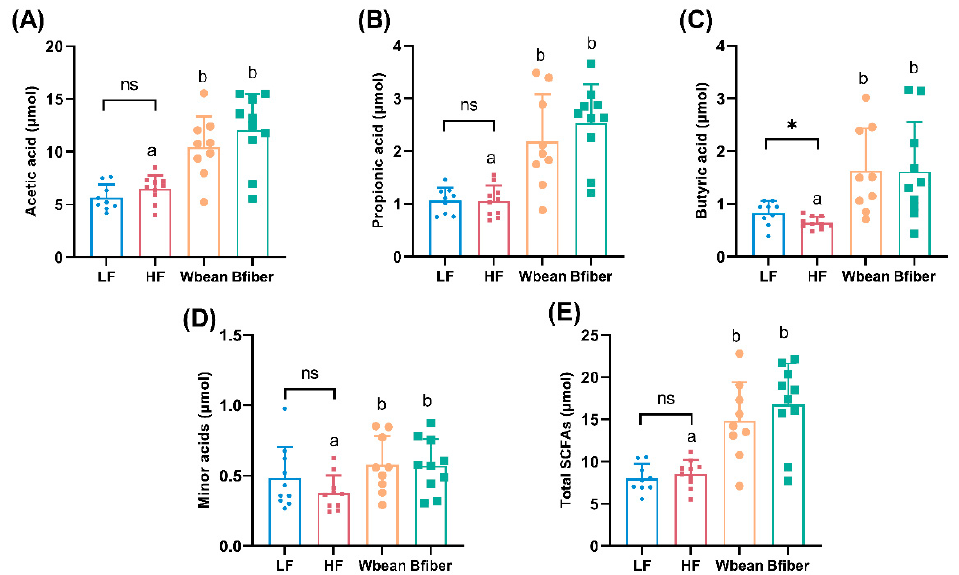
Figure 2. Cecal pools ( µ mol) of ( A ) acetic acid, ( B ) propionic acid, ( C ) butyric acid, ( D ) minor acids and ( E ) the total short-chain fatty acids (SCFAs) in Apoe − / − mice fed a control diet (low fat (LF) or high fat (HF)) or a bean diet (whole brown bean (Wbean), bean fiber (Bfiber)) in a HF setting for 10.5 weeks. Minor acids include isobutyric acid, valeric acid, isovaleric acid, caproic acid, and heptanoic acid. Values in the LF and HF controls were compared using Student’s t -test. Values in the high fat groups, i.e., HF, Wbean, and Bfiber, were compared using one-way ANOVA followed by Tukey’s multiple comparison test. Different lowercase letters and symbol (*) within panels indicate significant differences ( p < 0.05). ns: not significant.